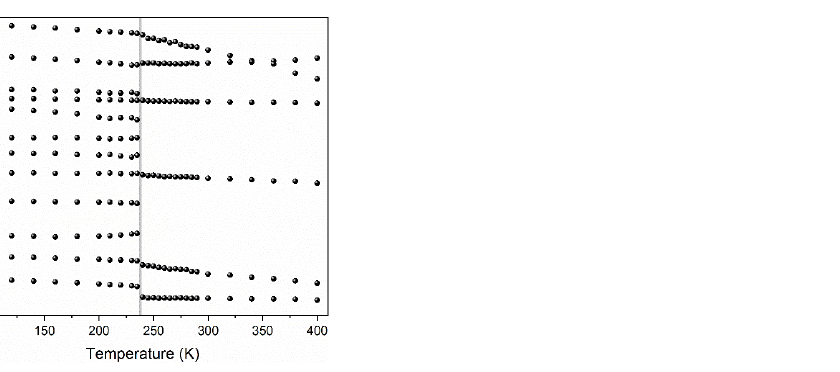
Figure 6. The temperature evolution of Raman lattice modes. The vertical grey line corresponds to the temperature of PT.